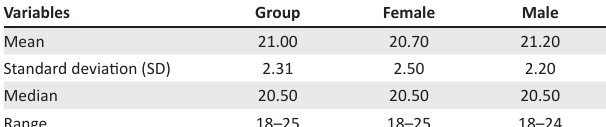
TABLE 1: Summary of subjects’ ages.